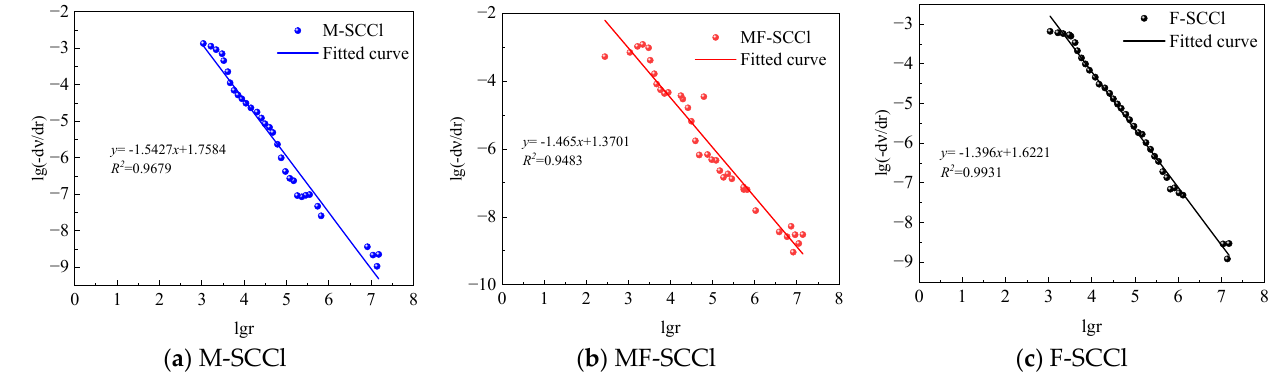
where v is the pore volume; r is the pore diameter; V is the fractal dimension of the pore volume. The fitting curves of the pore volume fractal dimension calculated for each group of specimens in the three-factor coupled environment are shown in Figure 10; the R 2 of each group was greater than 0.9, indicating that it had good fitting correlation. The pore volume fractal dimensions of M-SCCl, MF-SCCl and F-SCCl were 3.542, 3.465, and 3.396, respectively; the pore volume fractal dimension of M-SCCl was obviously the largest, followed by those of MF-SCCl and F-SCCl. It further confirmed that the incorporation of metakaolin could improve the pore structure of cement mortar under the coupling effect of three factors. Furthermore, the best performance in this environment was that of the single admixture of metakaolin. 8−10−8−6−4−2 F-SCCl M-SCCl MF-SCCl Fitted curve Fitted curve Fitted curve